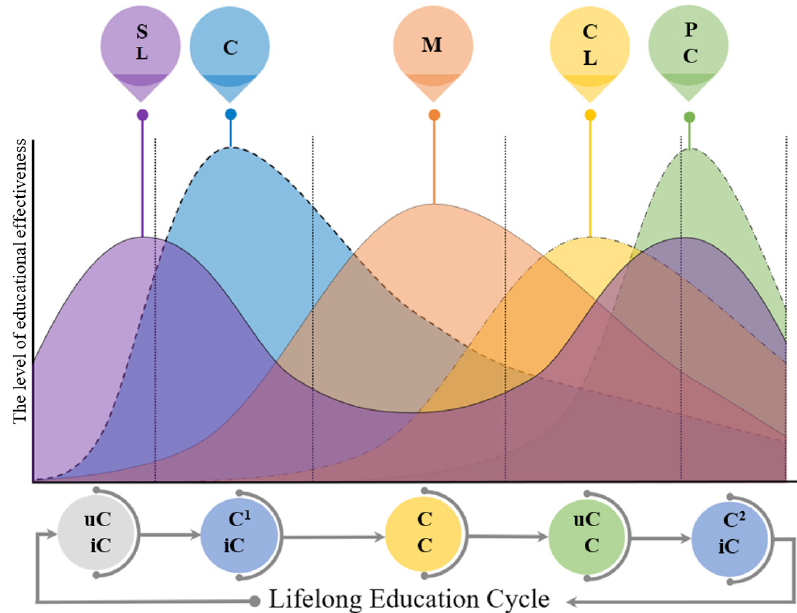
Figure 3. Interrelationship of processes in the development of creative entrepreneurial competences and self-management of an